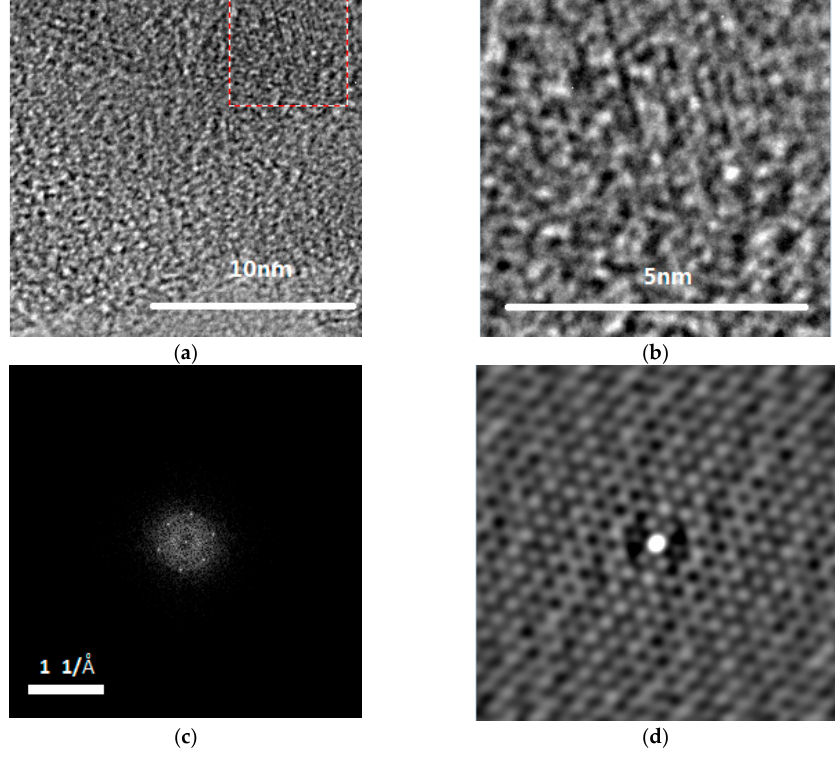
Figure 7. ( a ) image of HAP in bones of the Cololabis saira . Squares in dashed color lines indicate the selected areas for FFT; ( b ) inverse FFT; and ( c ) FFT pattern indicating the [001] view direction;